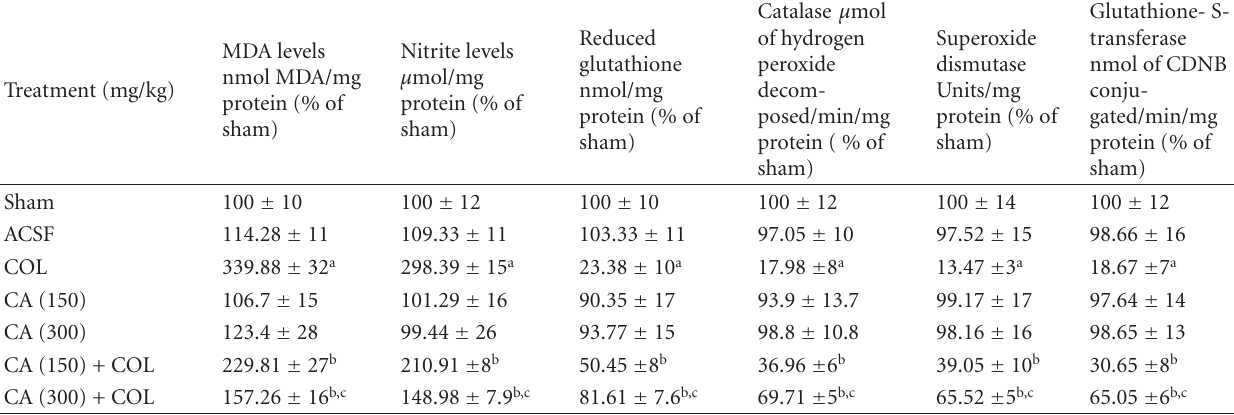
Table 4: E ff ect of Centella asiatica (CA; 150 and 300 mg/kg, PO) on colchicines-induced oxidative stress parameters in rat brain.